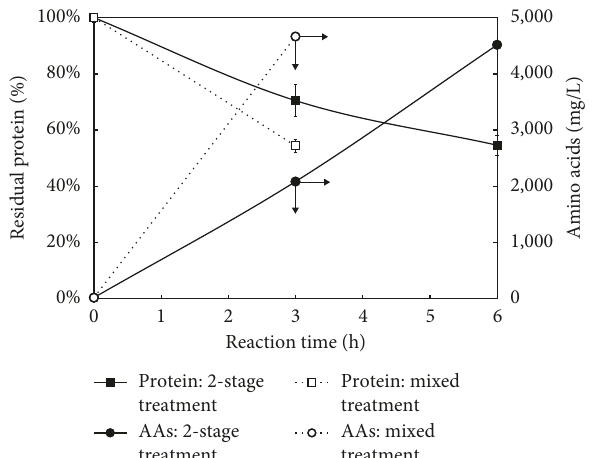
Figure 3: Comparison between the 2-stage and mixed treatments using FoodPro and Flavourzyme during the enzymatic hydrolysis of silk